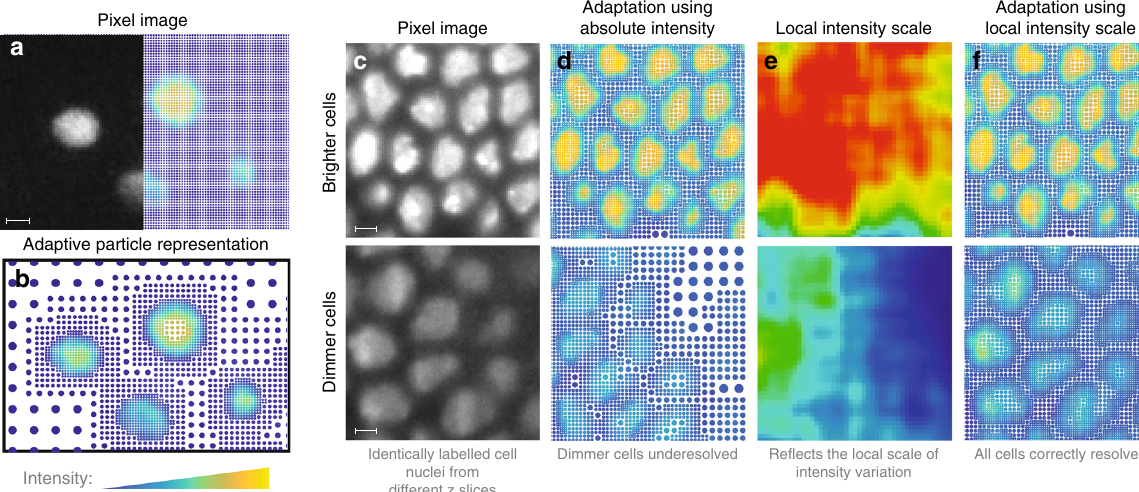
Fig. 1 Spatially adaptive representation of images. a Example image of fl uorescently labeled zebra fi sh cell nuclei (exemplar dataset 7, courtesy of Huisken Lab, MPI-CBG & Morgridge Institute for Research 25 ), represented on a regular grid of pixels. b The APR of the same image. Particles are shown as dots with their color indicating fl uorescence intensity and their size re fl ecting the local resolution of the representation. c – f Adaptively representing objects of different intensity requires accounting for the local brightness levels. c Two regions of labeled cell nuclei (exemplar dataset 6, courtesy of Tomancak Lab, MPI-CBG) with different brightnesses. d Adaptive representation based on the absolute intensity. f The APR accounting for the Local Intensity Scale of the image as shown in e . In f , all objects are correctly resolved across brightness levels. Scale bars indicate 10